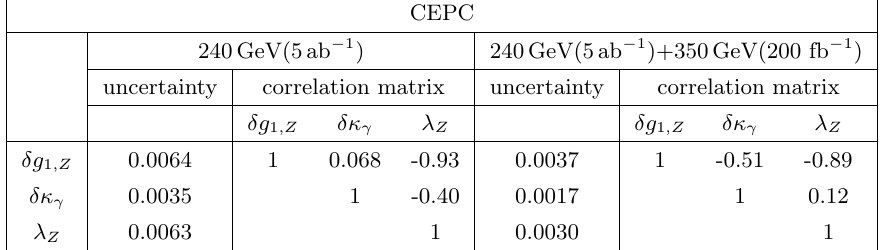
Table 5 . The constraints on aTGCs from the e + e methods described in section 3.4. Both the results from the 240 GeV run alone and the ones from the combination of the 240 GeV and 350 GeV runs are shown.